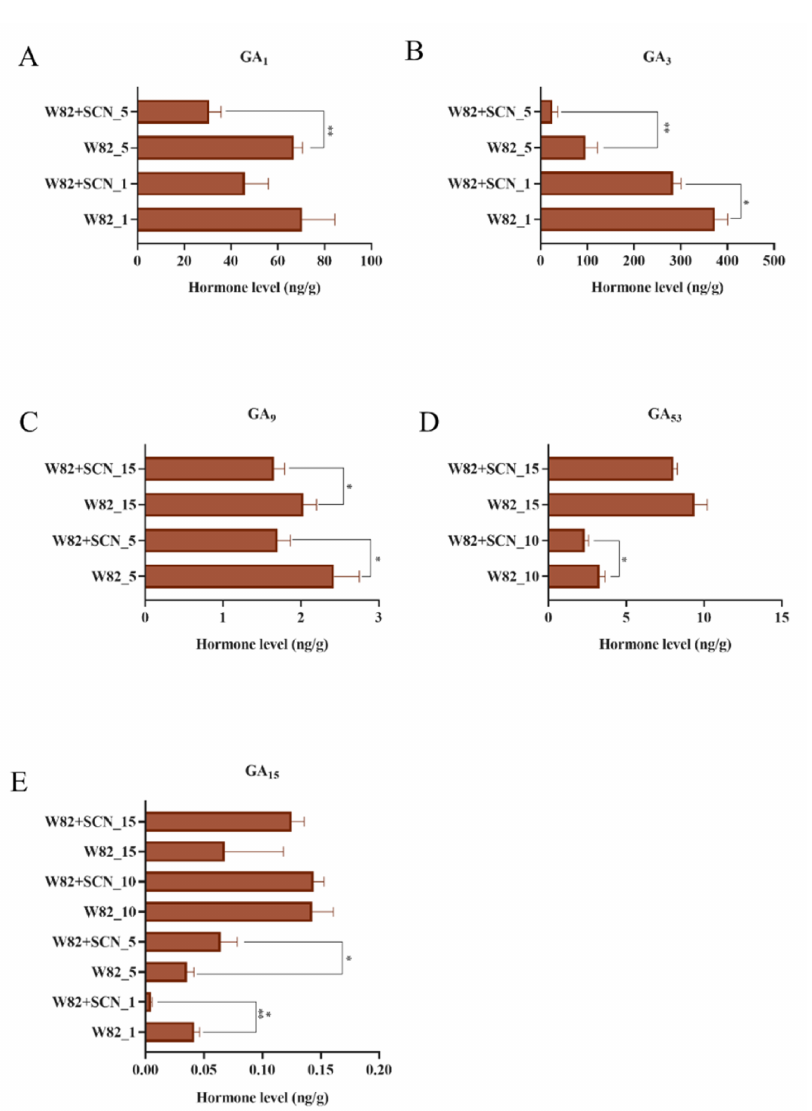
Figure 10. Endogenous GAs content changes in soybean cultivar Williams 82 roots infected by the SCN. ( A – E ) Content of GA 1 , GA 3 , GA 9 , GA 53 and GA 15 in soybean roots. W82_1, W82_5, W82_10 and W82_15. Williams 82 control at 1, 5, 10 and 15 dpi, likewise, W82 + SCN_1, W82 + SCN_5, W82 + SCN_10 and W82 + SCN_15. Williams 82 inoculated with SCN at 1, 5, 10 and 15 dpi. dpi, day post inoculation. t -test was applied to detect the differences of GA content. Error bars represent the standard deviation from the means. *, ** and ***, significant difference found at p < 0.05, p < 0.01 and p < 0.001